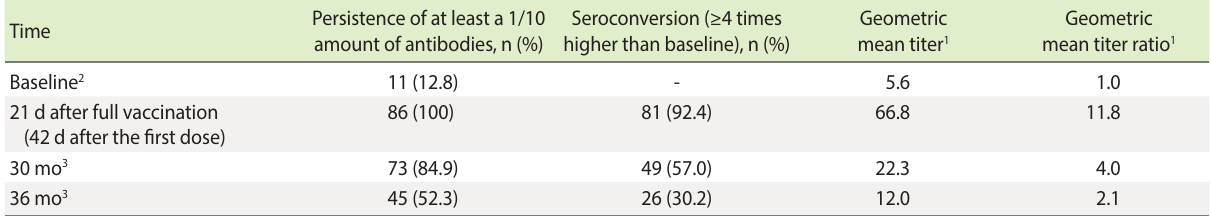
Table 1. Prevalence of persistence of at least a 1/10 amount of A/H5N1 antibodies and seroconversion (≥4 times higher levels compared to baseline) among participants